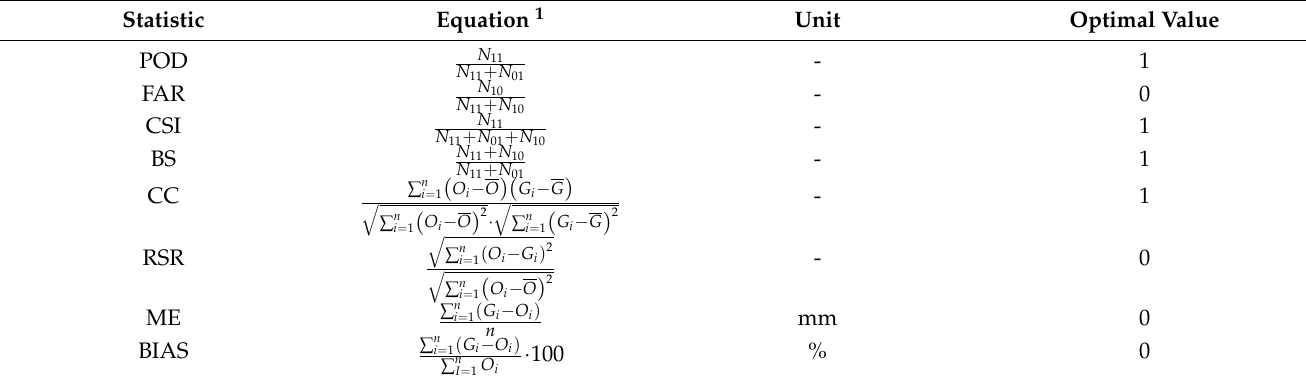
Table 2. Precipitation performance metrics.